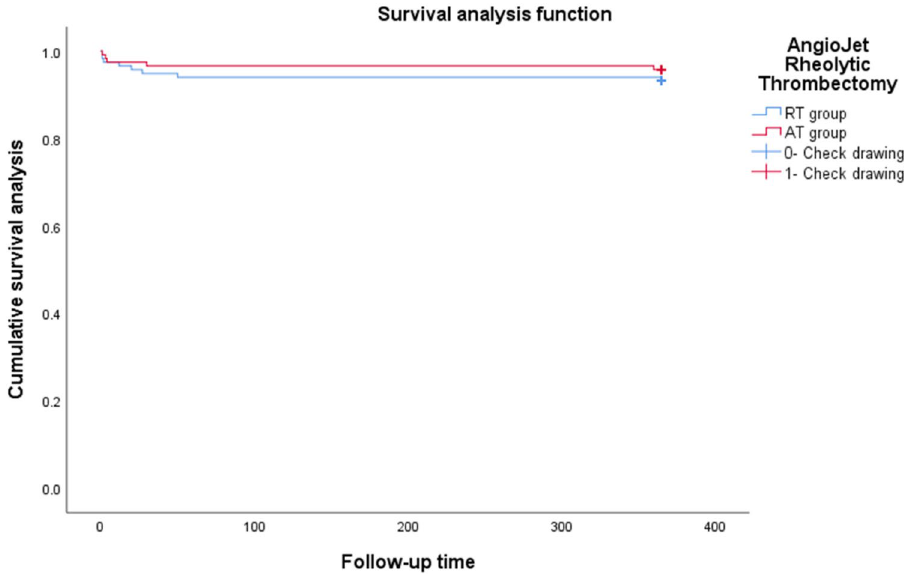
Figure 2. Kaplan–Meier curves for death from any